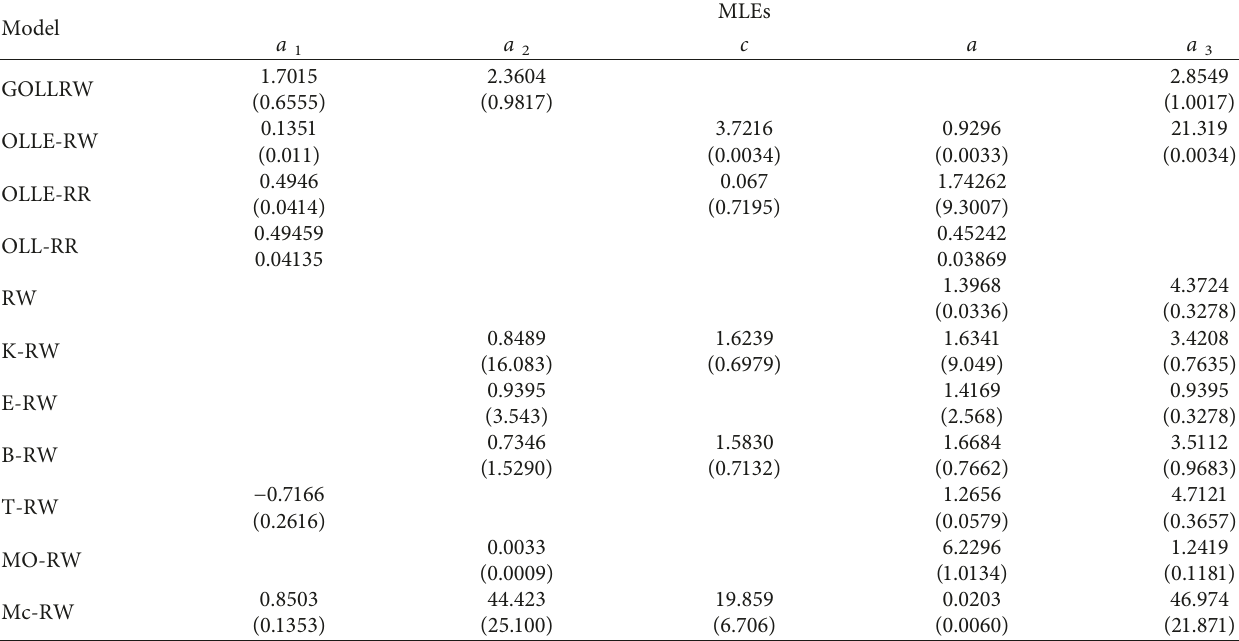
Table 9: MLEs (SEs) for stress data